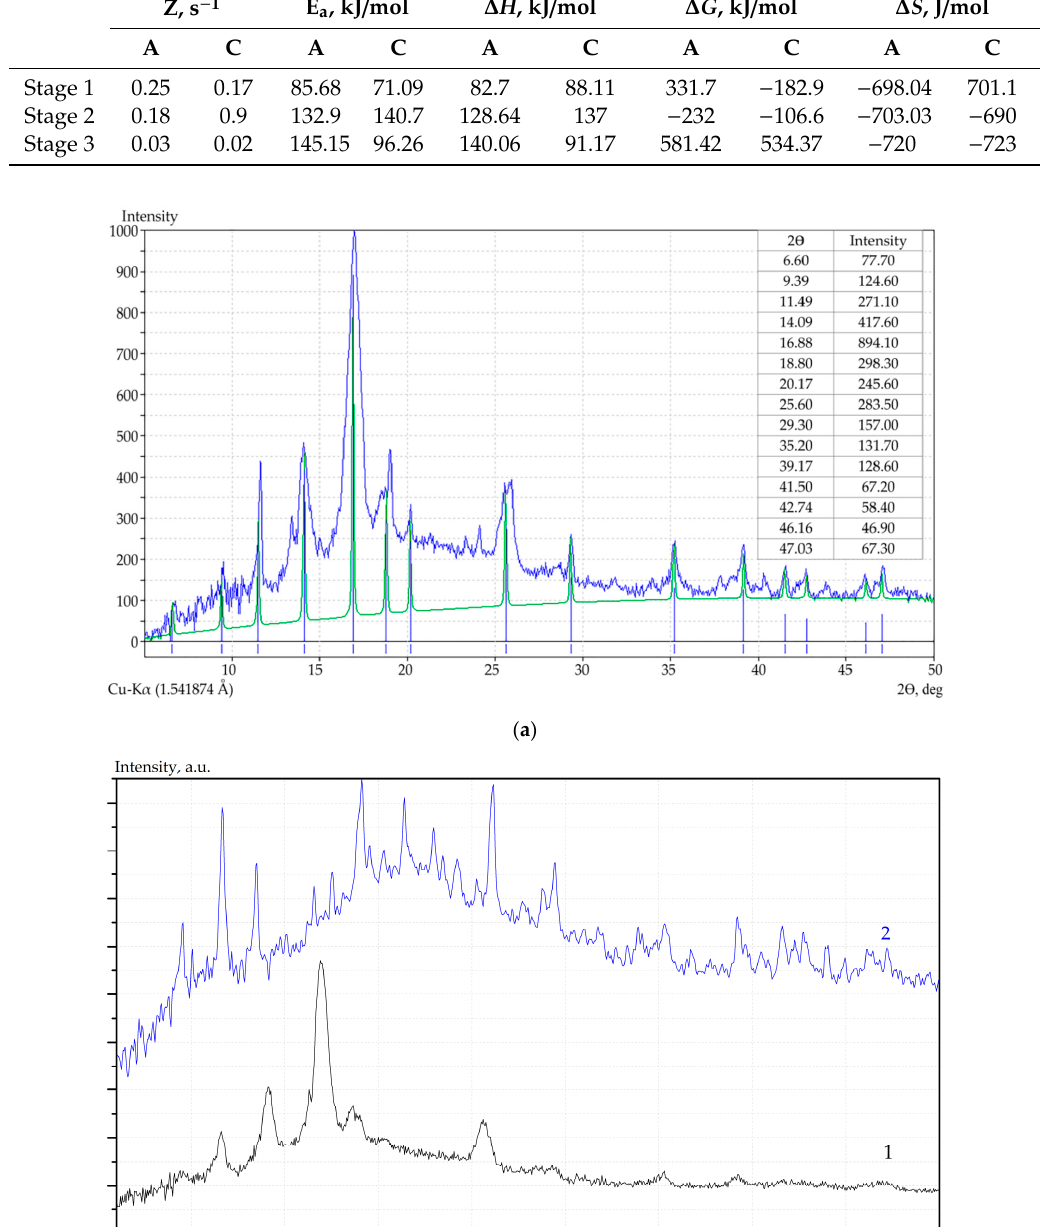
Table 2. Kinetic and thermodynamic parameters of the decomposition reaction of copper trimesinate synthesized according to methods A and C.